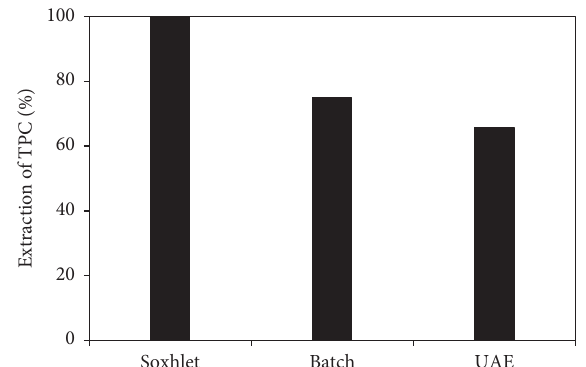
Figure 5: Comparison of extraction methods for particle size 0.425mm, solid-to-solvent ratio 1:40 (g/mL), and solvent con- centration of 50% (v/v) MeOH-water.